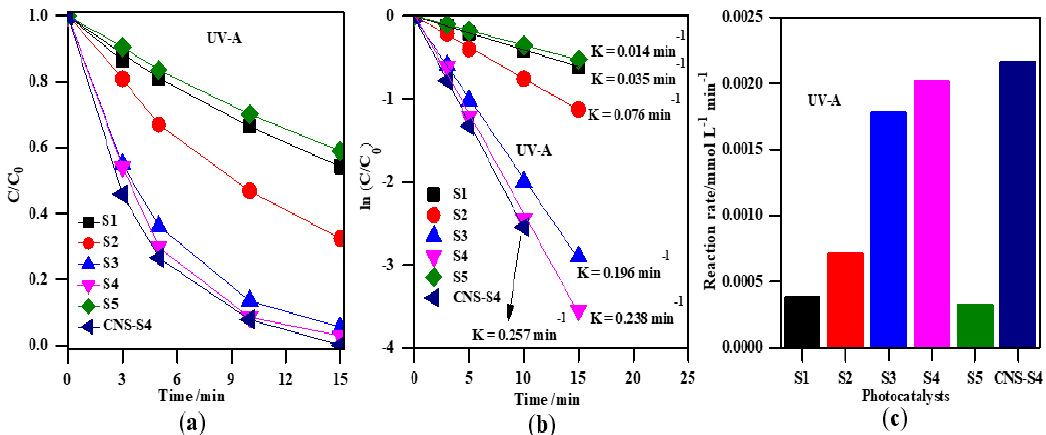
Figure 7. ( a ) change of the MC-LR concentration during irradiation; ( b ) plot of ln (C/C 0 ) versus irradiation time; ( c ) comparison of the degradation rate of MC-LR using S1, S2, S3, S4, S5, and CNS-S4 photocatalysts under UV-A light. Catalyst loading, 0.4 g L − 1 ; MC-LR dose, 10 mg L − 1 ; pH, 4; T, 25 ◦ C; reaction volume 40 mL.